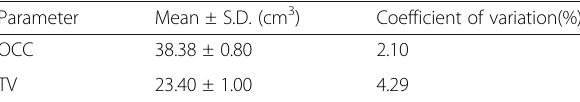
Table 1 The mean coefficient of variation from ten times repeated VPS method taken in the same subject